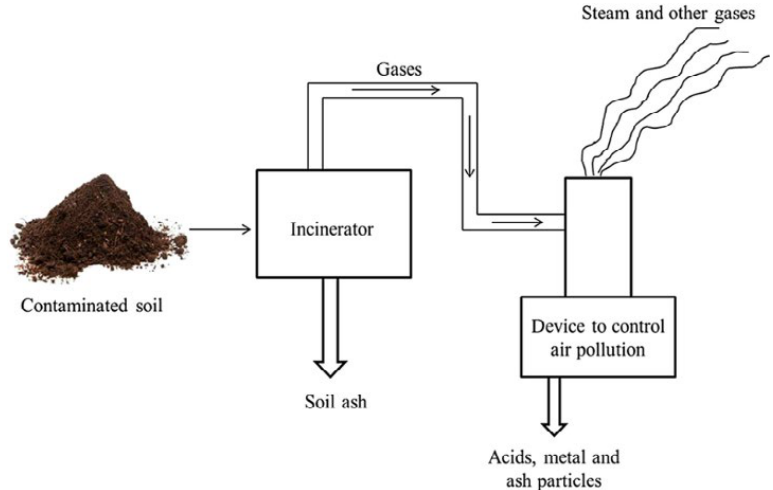
Fig. 3: Incineration of contaminated soil (Koul and Taak, 2018)